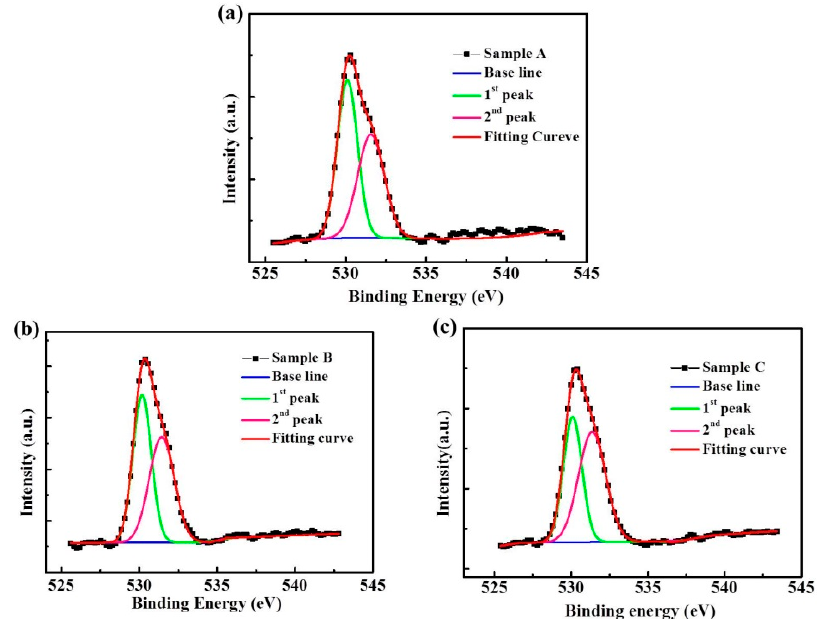
Figure 7. O1s XPS spectra of ( a ) samples A, ( b ) sample B, and ( c ) sample C under various sputtering power.